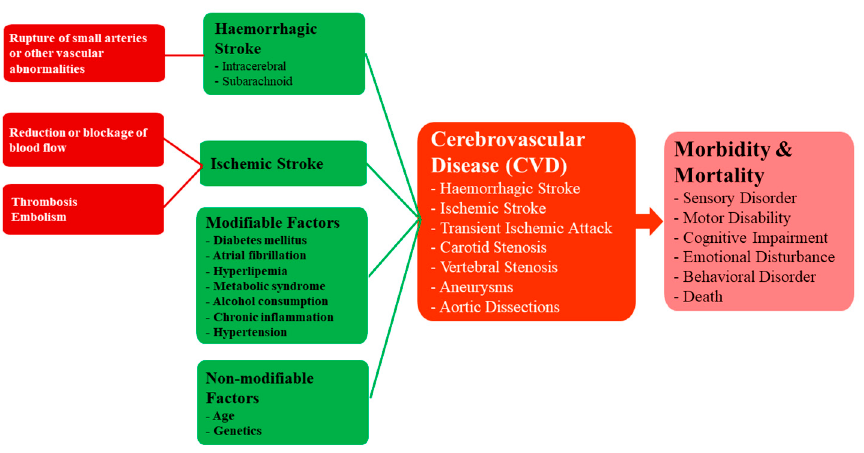
Figure 5. A framework for understanding the causes and consequences of CVD.